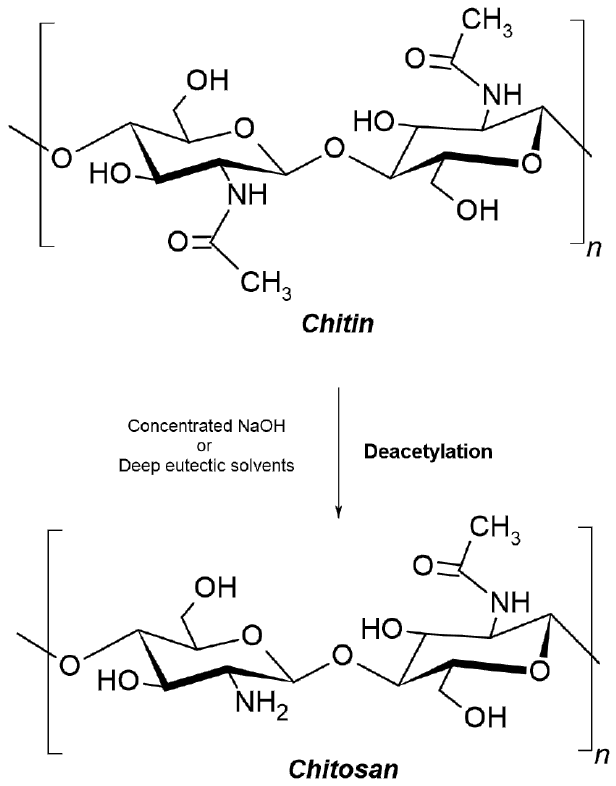
Figure 8. Deacetylation of chitin to chitosan.